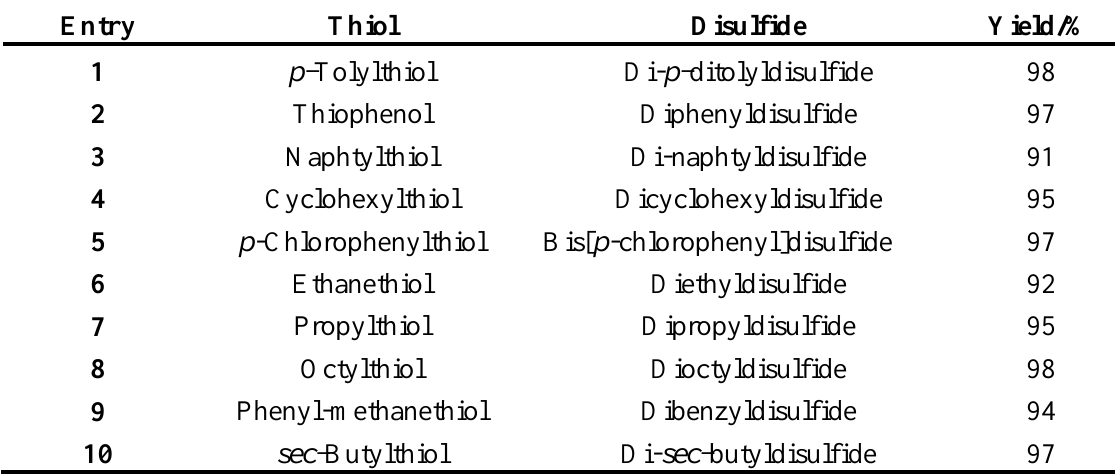
Table 2. Oxidation of thiols to